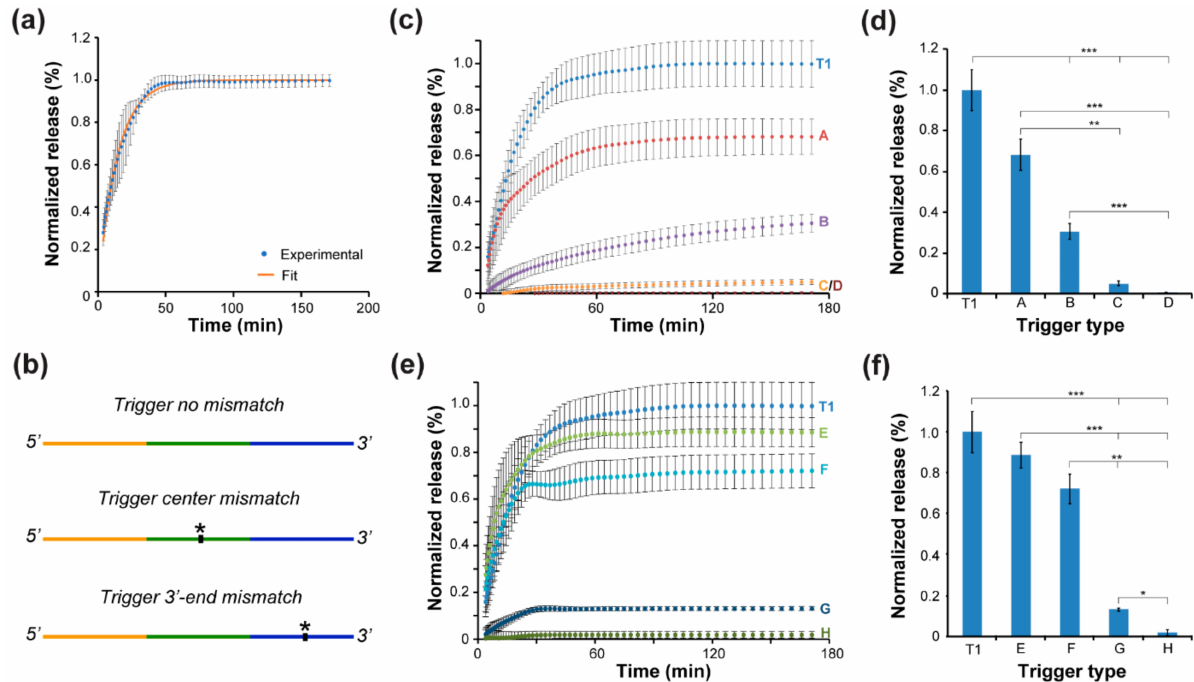
Figure 3. 4WJ controlled release in solution ( a ) 4WJ-HEX release curve with regular trigger in solution. ( b ) Schematic of the mismatch design. The mismatch location is denoted with *. ( c ) 4WJ-HEX release curve with varying center mismatched trigger. ( d ) Bar graph representation of the release curve shown in ( b ) (Dunn’s Kruskal–Wallis multiple comparison, ** = p < 0.01, *** = p < 0.001). The trigger type label corresponds to the label shown in SI (Table S1). ( e ) 4WJ-HEX release curve with varying 3 (cid:48) mismatched trigger. ( f ) Bar graph representation of the release curve shown in ( b ) (Dunn’s Kruskal– Wallis multiple comparison, * = p < 0.05, ** = p < 0.01, and *** = p < 0.001). The labeling of trigger type is corresponding to the DNA sequence shown in Table S1. The release was normalized against the positive control, which is the DNA motif without the